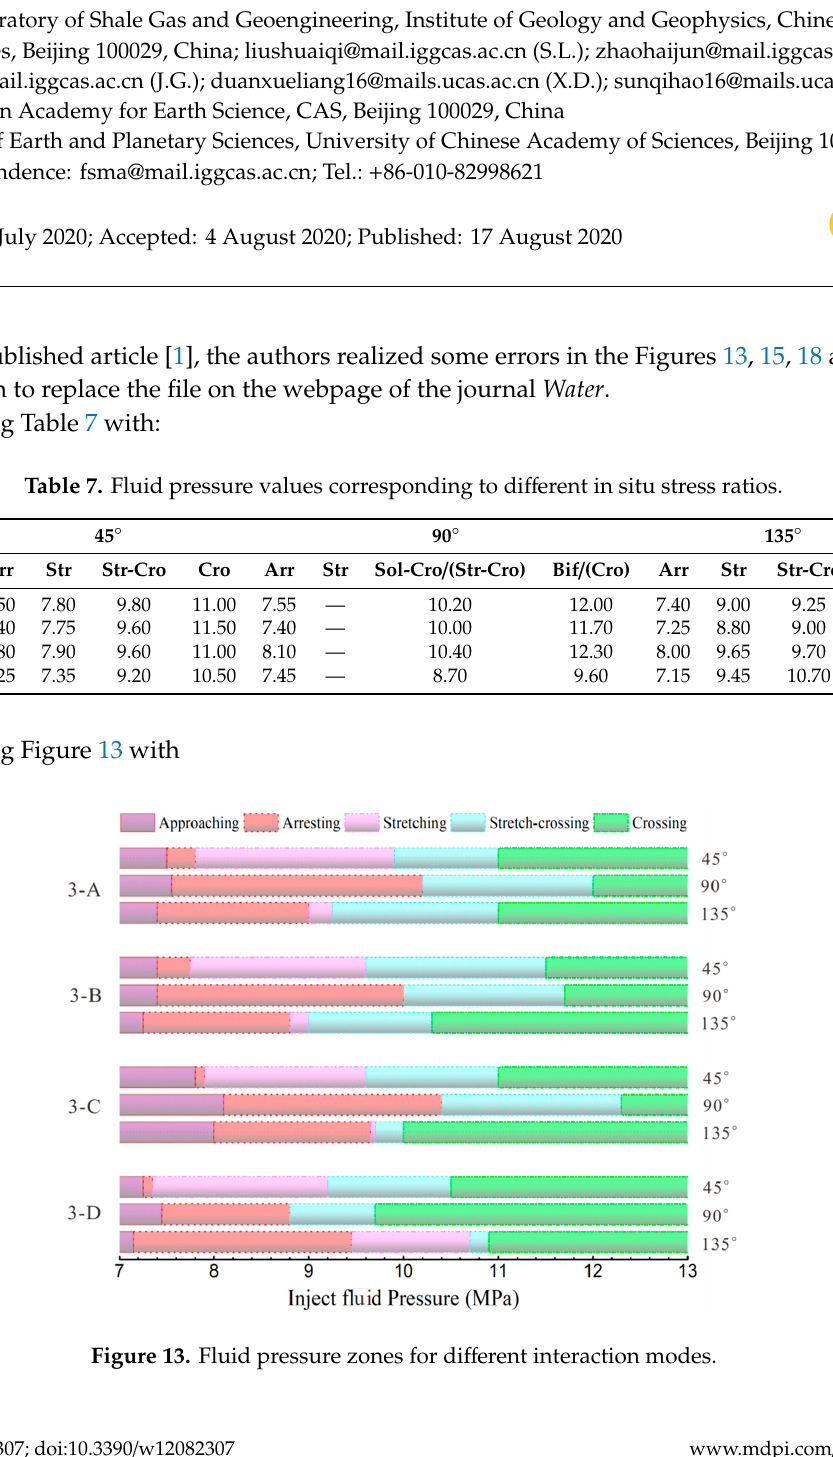
Figure 15. Fluid pressure zones for different interaction modes.